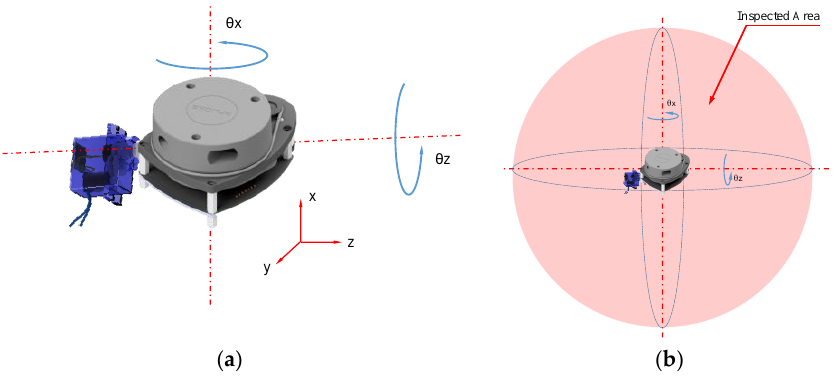
Figure 9. ( a ) Functionality of the system; ( b ) Survey volume.